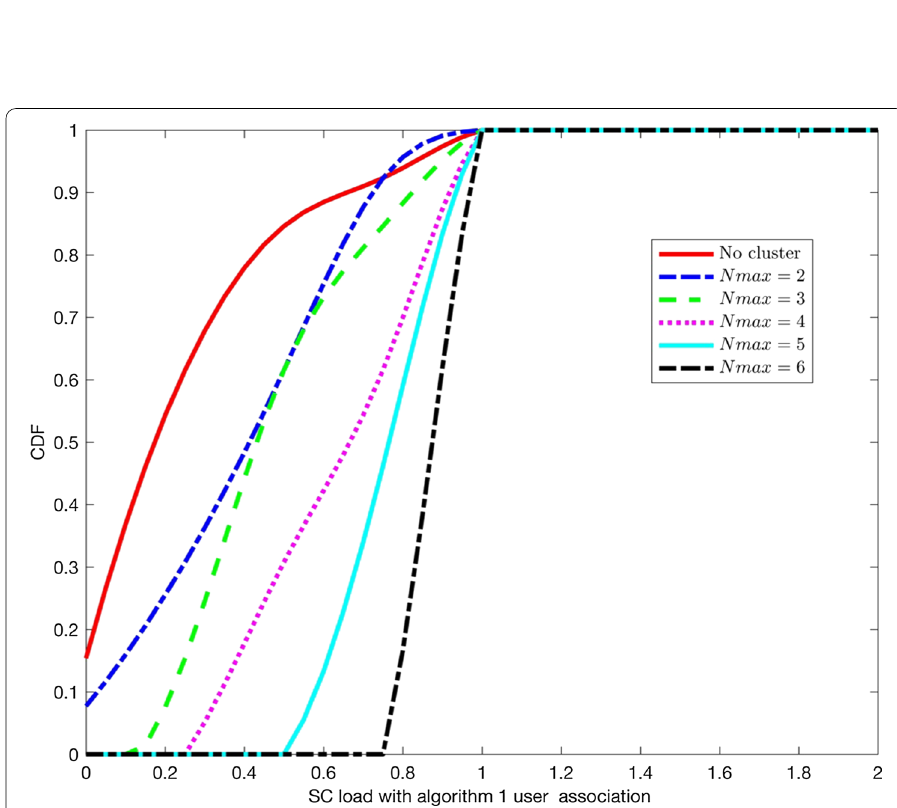
Fig. 5 SC load of algorithm 1 user association with 350 UE/km 3 and 50 SBS/km